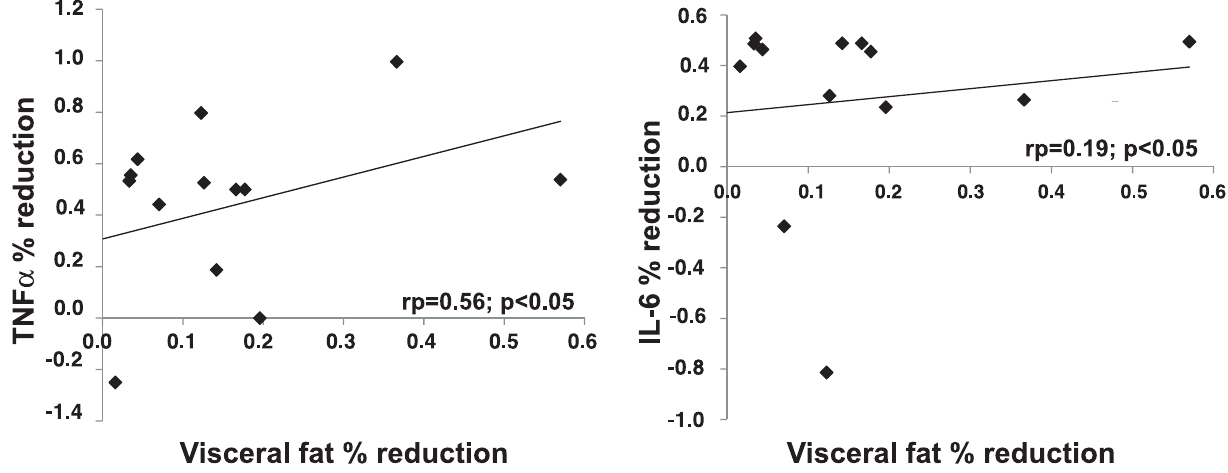
Figure 1. Correlation between percent visceral fat reduction and percent plasma IL-6 and TNF- a levels reduction in the study